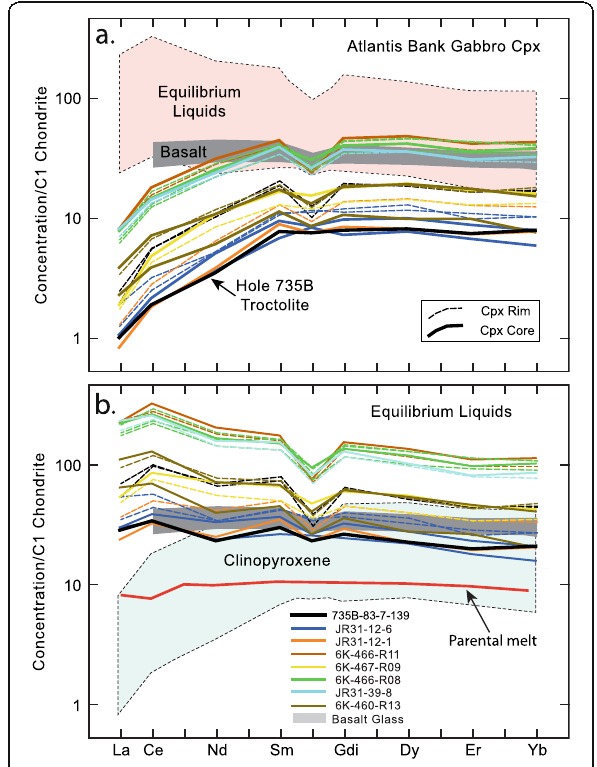
Fig. 10 a REE concentrations in gabbro augite from dredges, dives, and drilling at Atlantis Bank normalized to the C1 chondrite values of Anders and Grevesse (1989). Gray field for Atlantis Bank and Segment 19 (Cannat et al. 1999) SWIR basalts is from Johnson and Dick et al. (1992). Pink field for equilibrium liquids is from panel b . b Equilibrium liquids calculated using the REE partition coefficients of Sobolev and Shimizu (1992). Heavy black line is the Hole 735B troctolite from core 83-7. Blue field for Atlantis Bank augite is from panel a . Parental melt representing 5% melting of the hypothetical DMM composition of Workman and Hart (2005) is shown for comparison by the heavy red